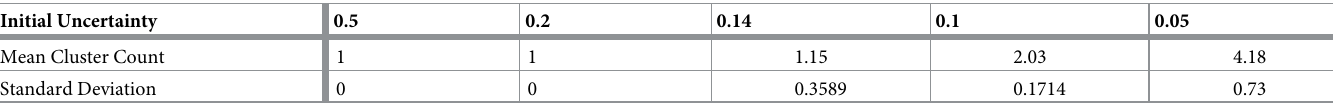
Table 1. The mean cluster count for each 100 simulations of the HK bounded confidence under different values of � . � 0.05 0.1 0.15 Mean Cluster Count 1.99 1 Standard Deviation 0.6432 0.4845 0.4824 0.1 0 0 Cluster counts were found using the inbuilt Matlab function subclust .